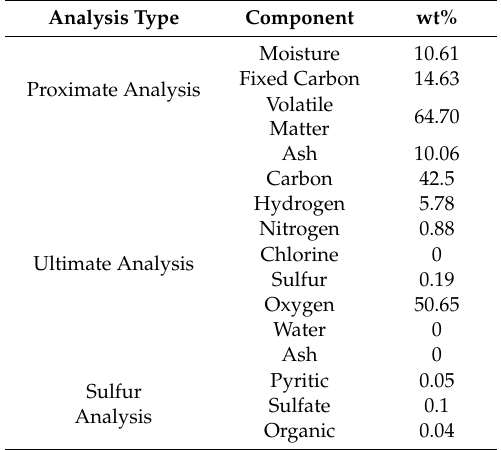
Table 1. Proximate analysis, ultimate analysis, and sulfur analysis of date palm waste